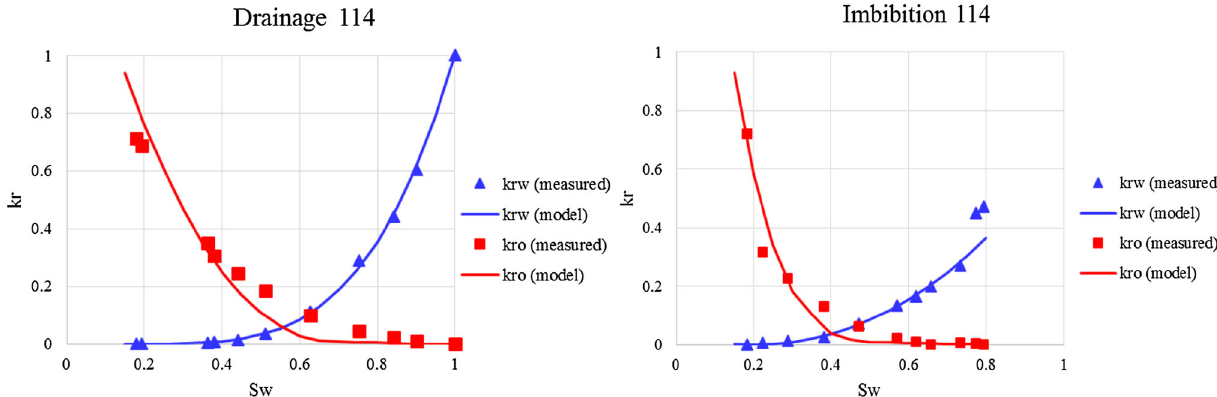
Fig. 11 Drainage and imbibition K r correlation for sample plug #114